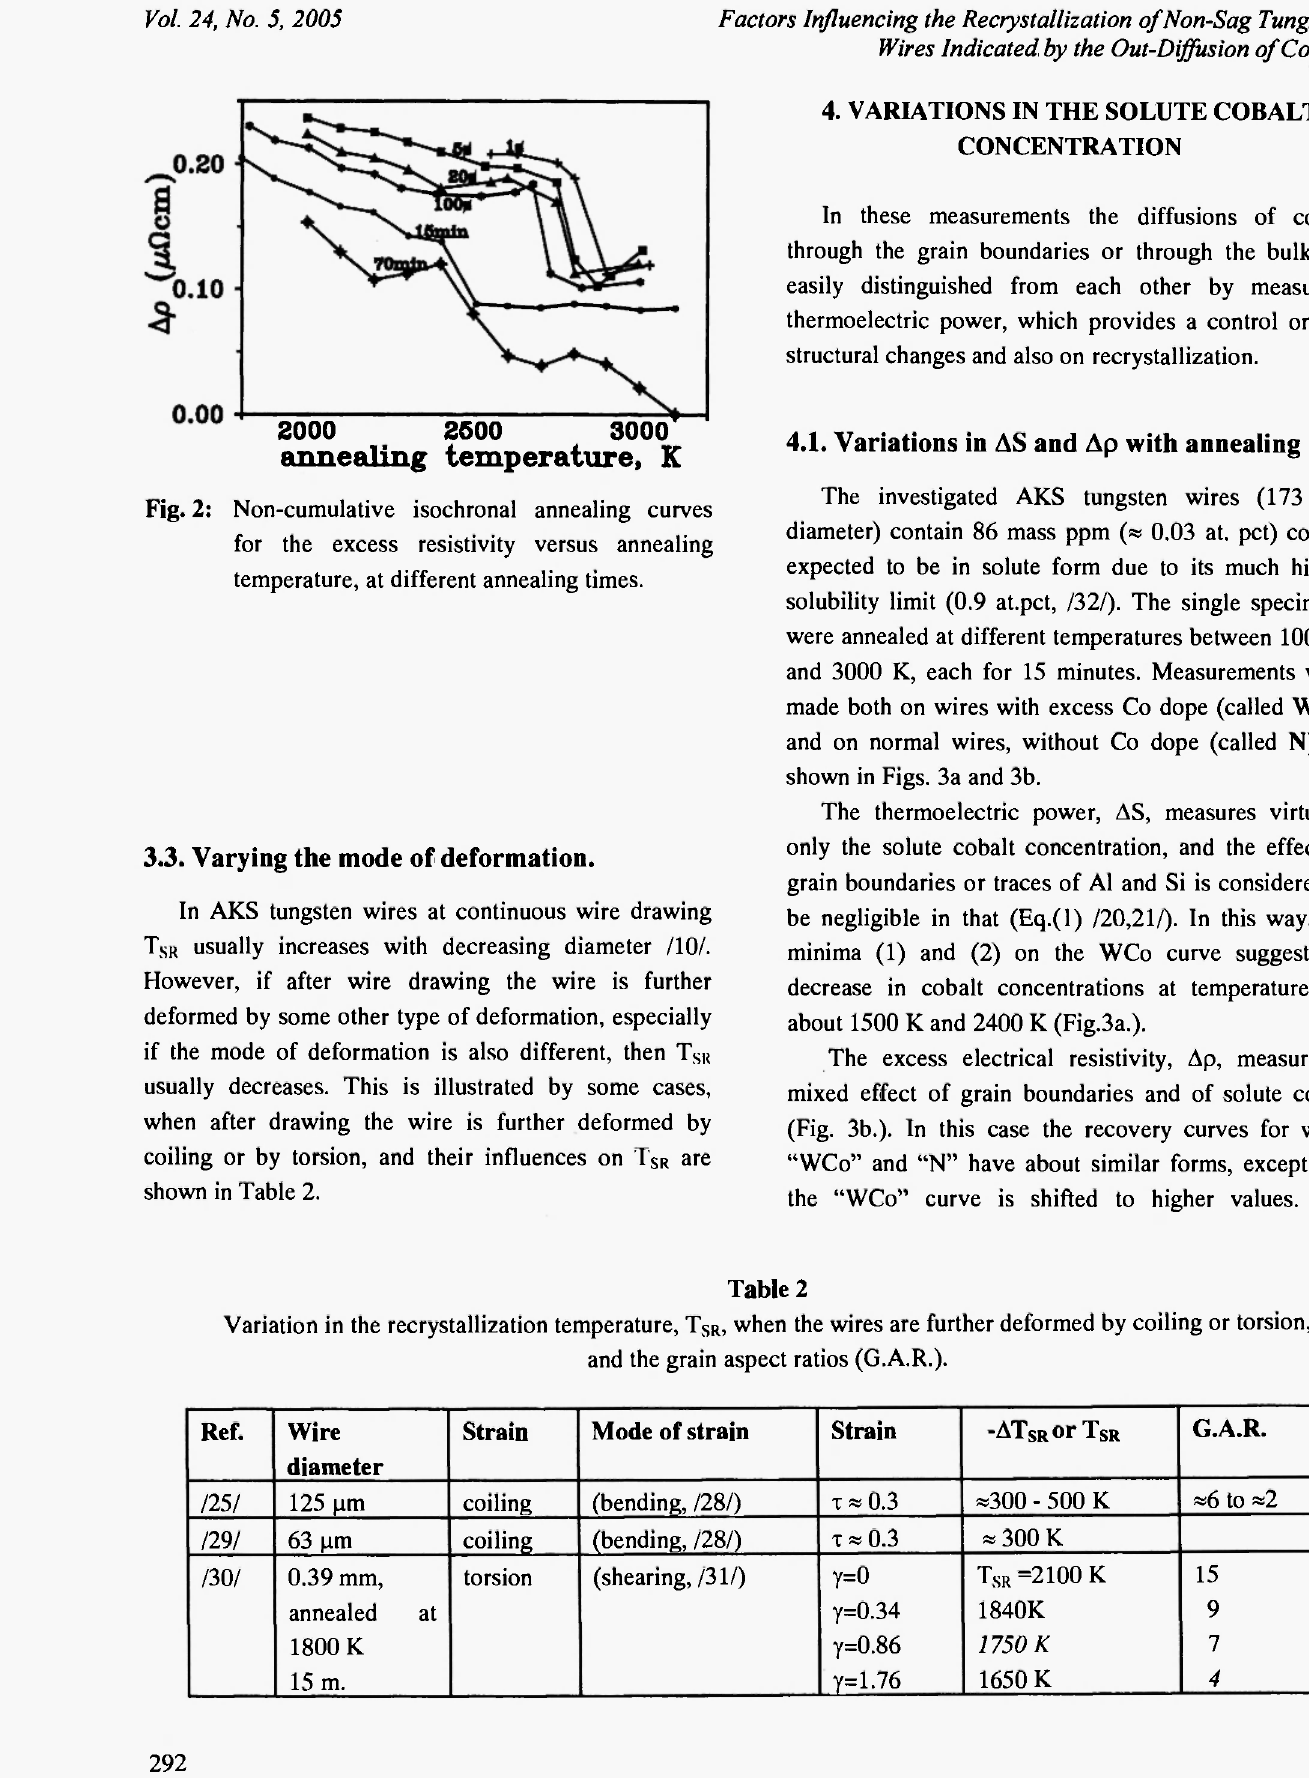
Fig. 2: Non-cumulative isochronal annealing curves for the excess resistivity versus annealing temperature, at different annealing